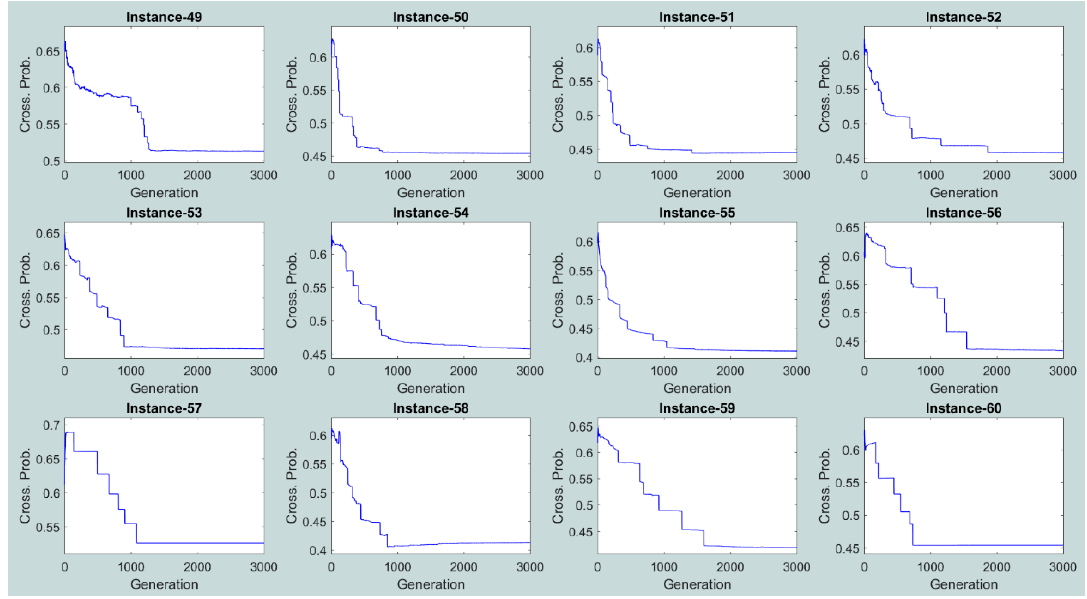
Figure 11. Evolution of the average crossover probability values for problem instances 49–60.